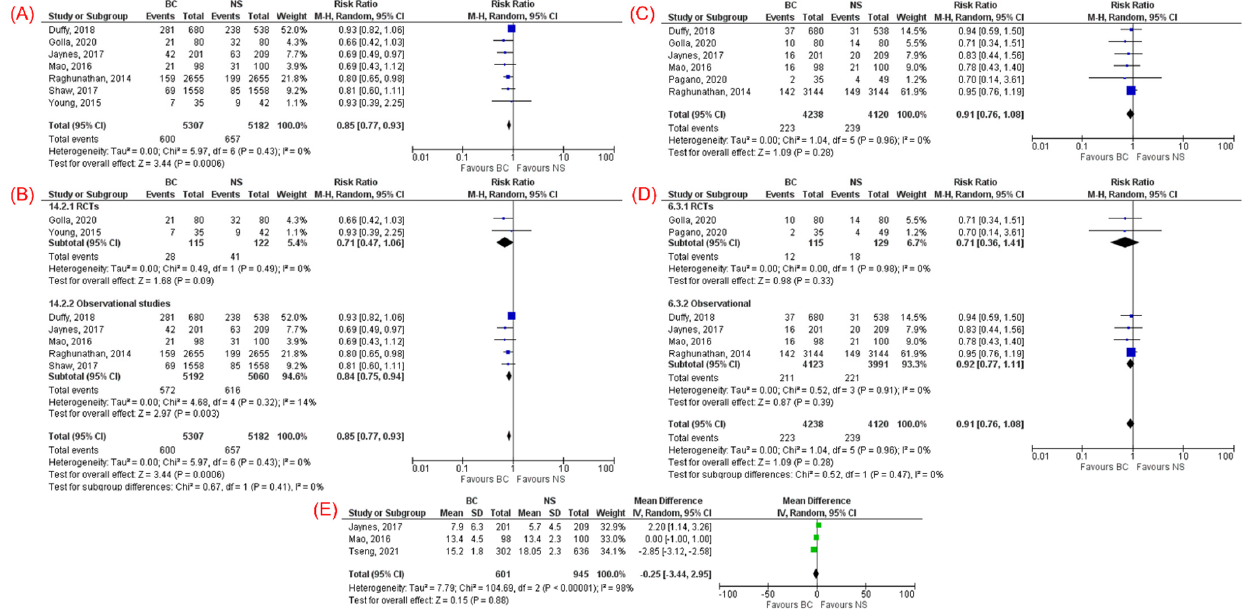
Figure 4. Forest plots comparing balanced crystalloids and normal saline regarding: ( A ) acute kid- ney injury, ( C ) need for renal replacement therapy, and ( E ) intensive care unit length of stay. Subgroup analysis based on study design (RCTs vs. observational studies) for ( B ) acute kidney injury and ( D ) need for renal replacement therapy.